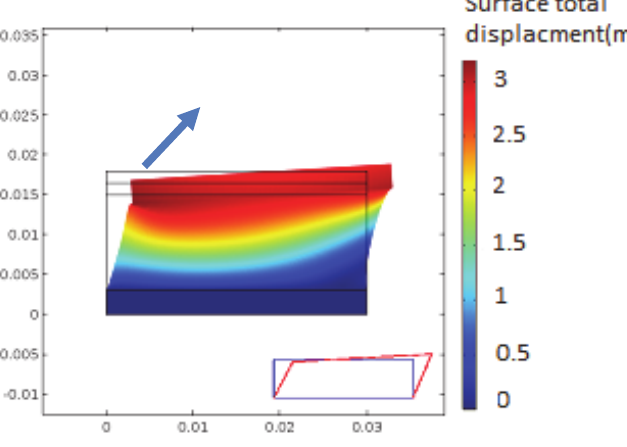
Fig. 13: joint deformation under a force of 1e4 N/m applied on a free rotation point; comparison between FEA and spring model.